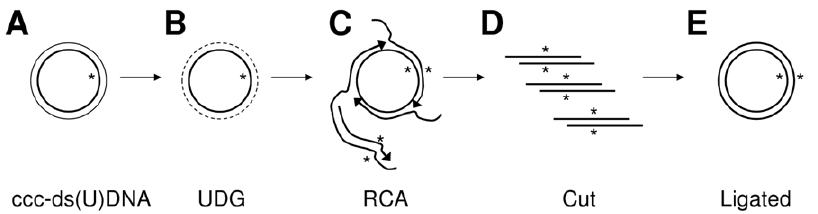
Figure 1. Selective rolling circle amplification (RCA) flowchart. The heteroduplex, ccc-ds(U)DNA formed in Kunkel mutagenesis (A), is treated with UDG (B) and subsequently amplified with RCA (C) using random hexamers as primers. The resulting DNA concatemer is cut to plasmid-sized units (D) and re-circularized by self-ligation (E) for host transformation.